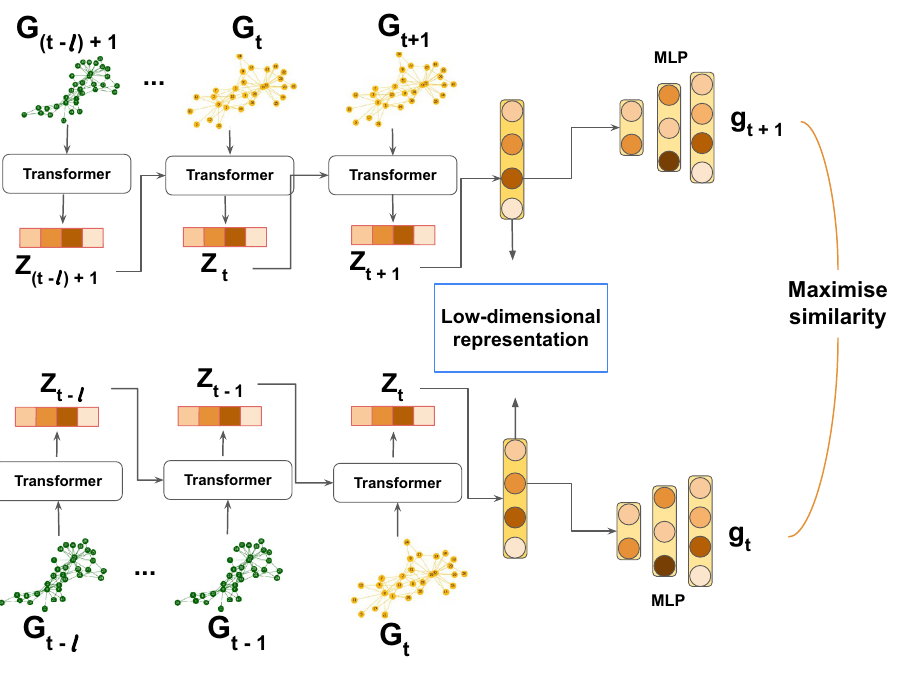
Figure 9. Overview of the method proposed in this